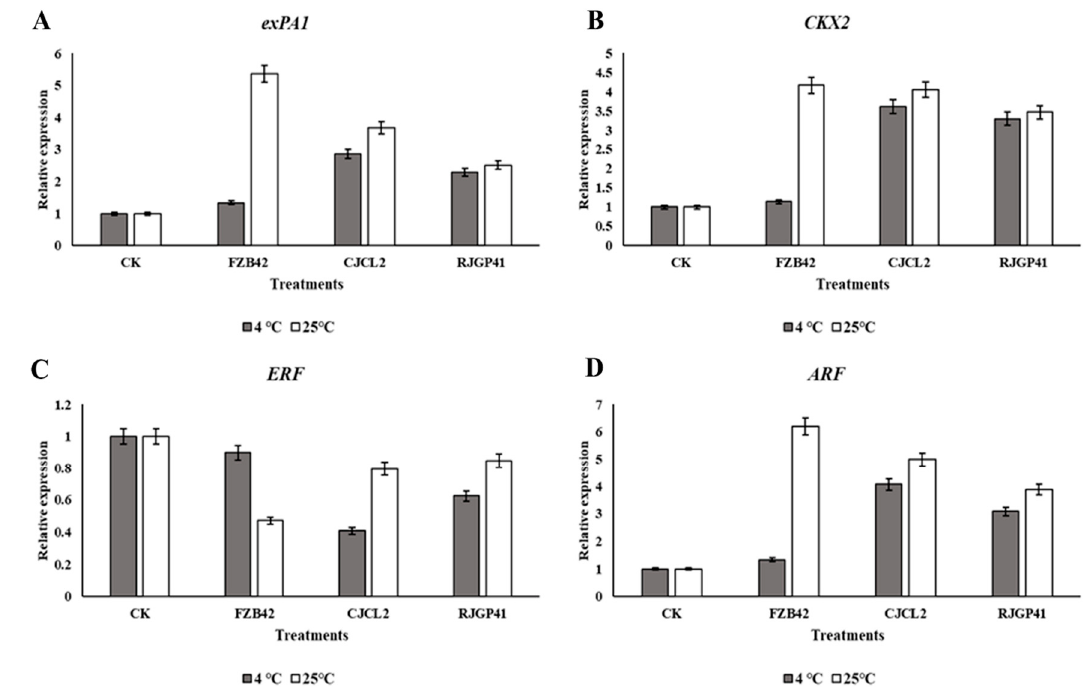
Figure 13. Relative expression level of expansin ( exPA1 ) in wheat plants inoculated with different Bacillus strains grown under cold stress and at regular temperature ( A ), Relative expression level cytokinin encoding gene ( CKX2 ) ( B ) Relative expression level of ethylene encoding gene ( ERF ) ( C ) Relative expression level Auxin ( ARF ) encoding gene ( D ). The error bars on the graphs indicates the standard deviation of the mean ( n = 3). The significant difference between the treatments was observed at p ≤ 0.05 by using Tukey’s HSD test. The expression analysis was done three times with similar results.